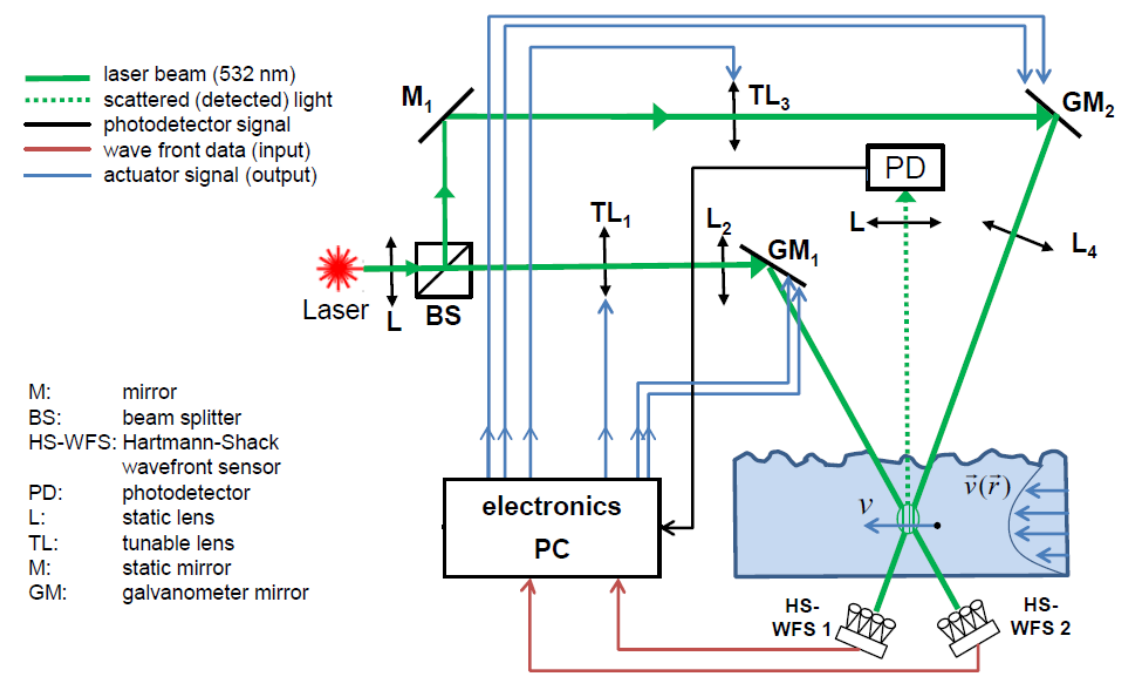
Figure 1. Smart laser Doppler velocimeter (LDV) interferometer with two implemented electrically tunable lenses (TL) and two two-axis galvanometer mirrors (GM). The smart LDV compensates the wavefront distortions caused by the fluctuating air-water interface. A twin control loop was realized to control both partial laser beams simultaneously. In the overlapping area of the two laser beams a fringe system is generated. The scattered light from tracer particles moving through this fringe system is measured by the photodetector (PD). In result the flow velocity v is